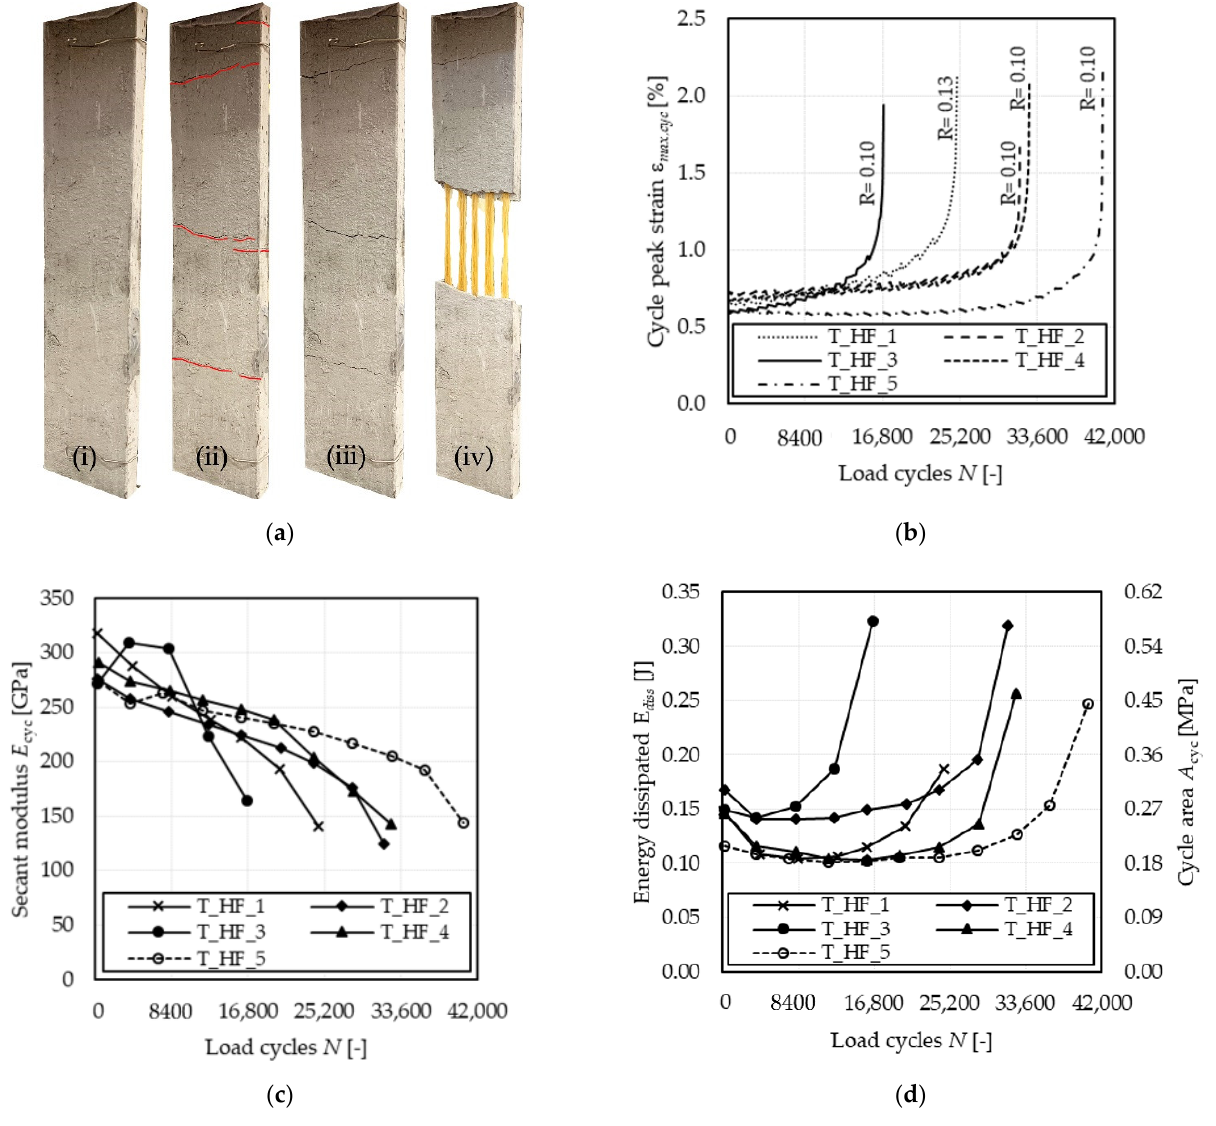
Figure 5. Effect of high-cycle fatigue on the tensile response of tested specimens. ( a ) Crack pattern during the test: (i) beginning of the test, (ii) end of the quasi-static phase, (iii) cyclic phase, (iv) failure. ( b ) Variation in cycle peak strain with the number of cycles. ( c ) Variation in the secant modulus with the number of cycles. ( d ) Variation in energy dissipated (cycle area) with the number of cycles.